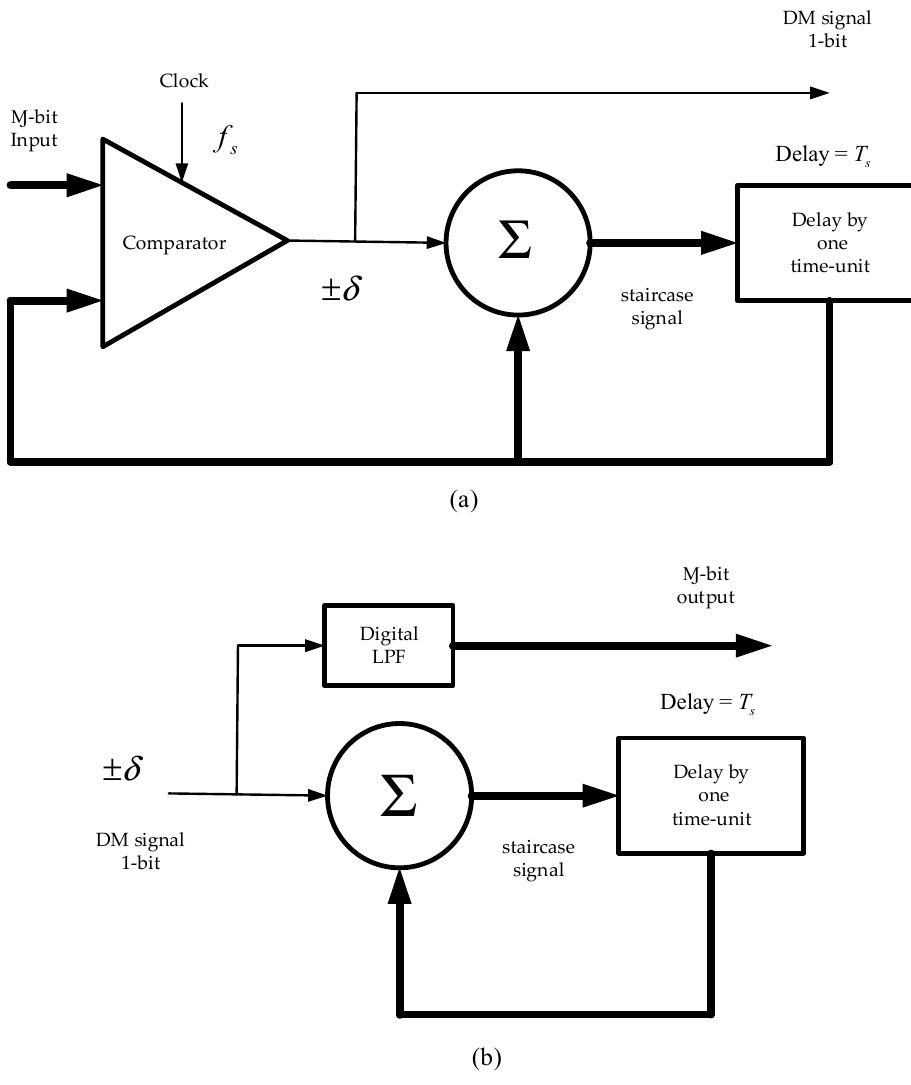
Figure 2. Delta modulation: ( a ) Transmission (DM modulator as a comparator and integrator in a feedback loop); ( b ) Reception (DM demodulator as an integrator and LPF).